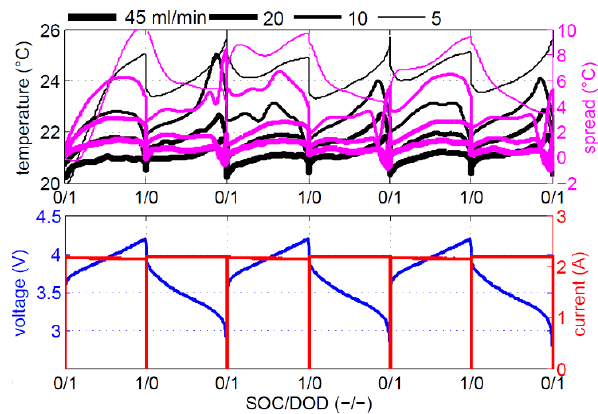
Fig. 4. The thermal performance (at the top) of the heat exchanger assessed by means of the mean temperature (black) and the temperature spread (magenta) of the cells in the range of flow rates (5–45 ) ml/min. Corresponding voltage and current during charging/discharging (at the bottom).